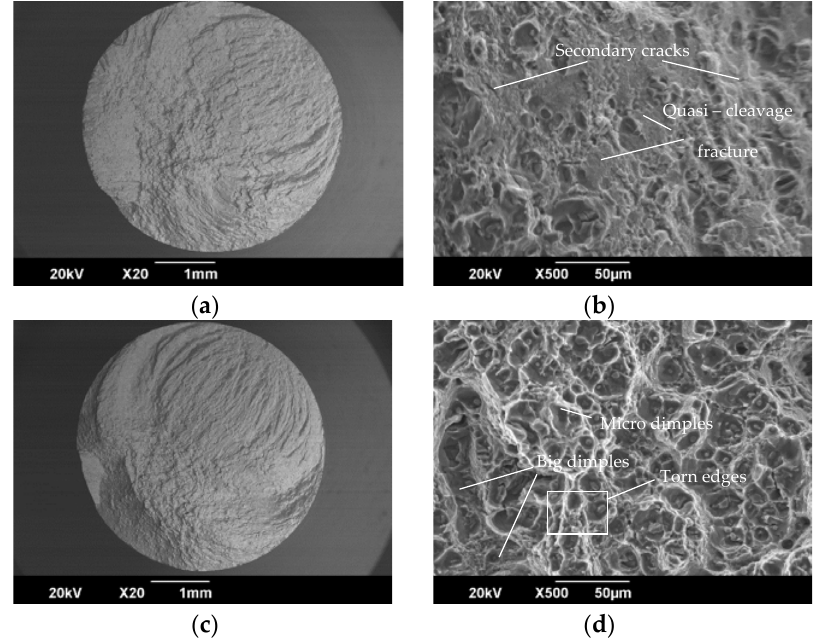
Figure 4. SEM images of AA2014-T6 fractured surface for untreated ( a , b ) and treated ( c , d ).